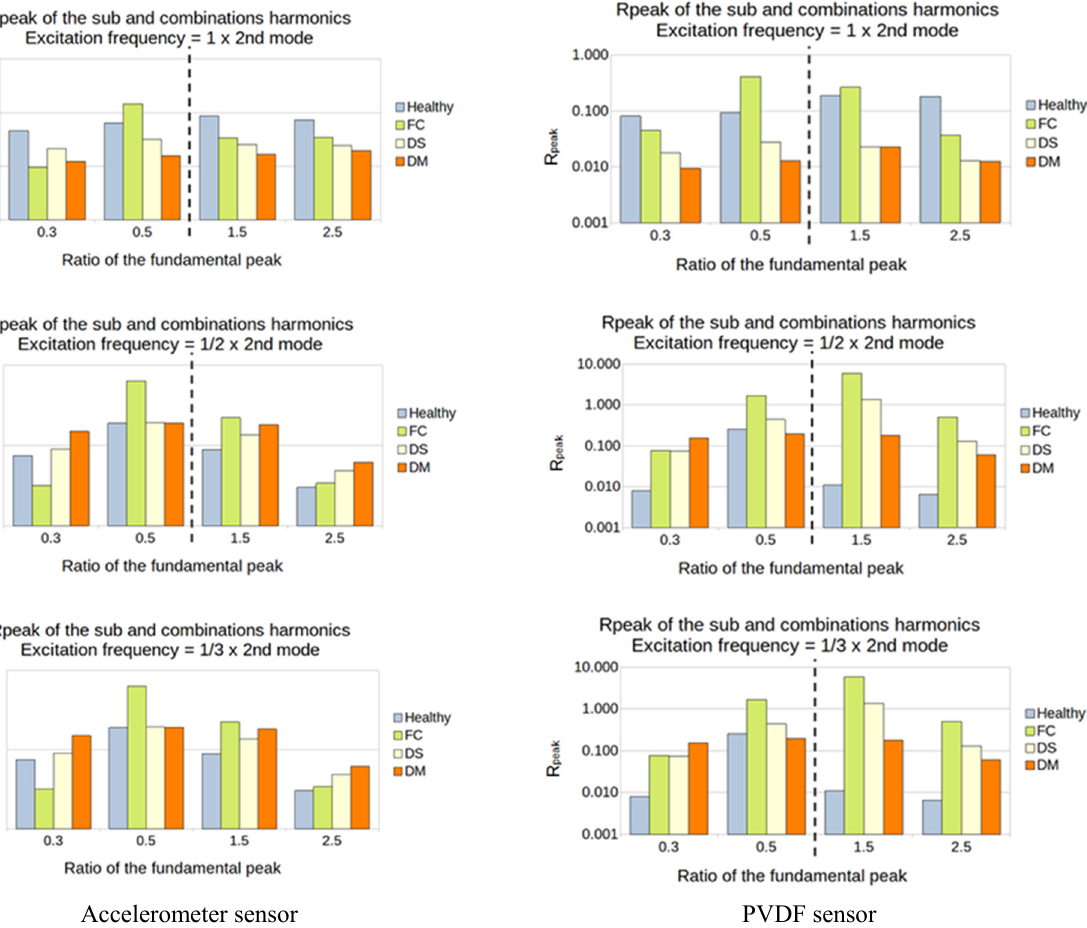
Figure 17. Second natural frequency and its ratio of 1, 1/2, and 1/3 as the frequency of excitation. For the third natural frequency, the PVDF showed sensitivity in every sub- and super-harmonics generation for the 1 and 1/3 excitation, while the accelerometer showed sensitivity only for the 1/3. However, the value of the ratio was weak, between 0.01 and 0.1% (Figure 18).